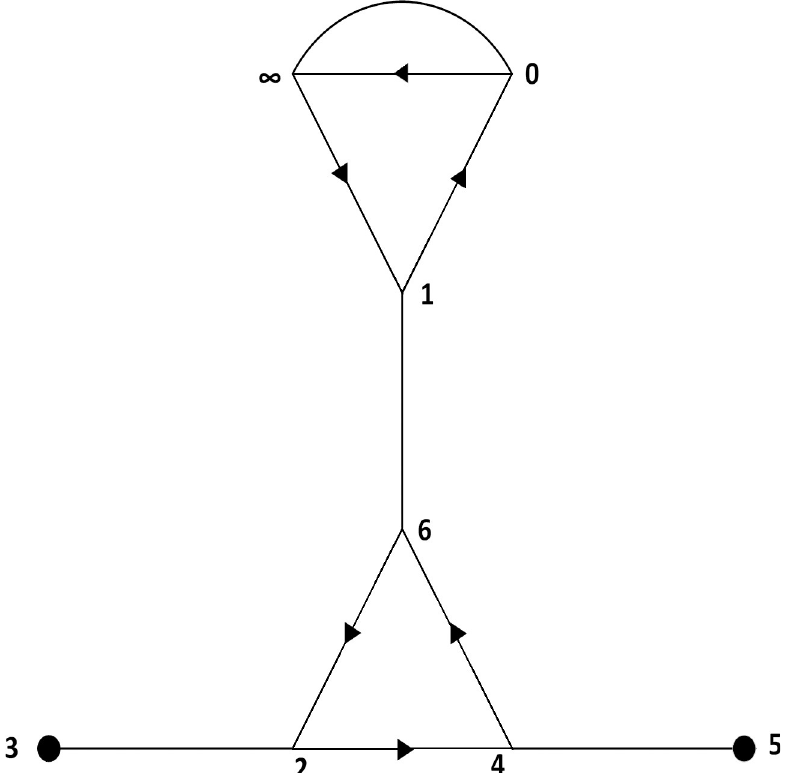
Fig 2. Coset diagram corresponding to the permutation group